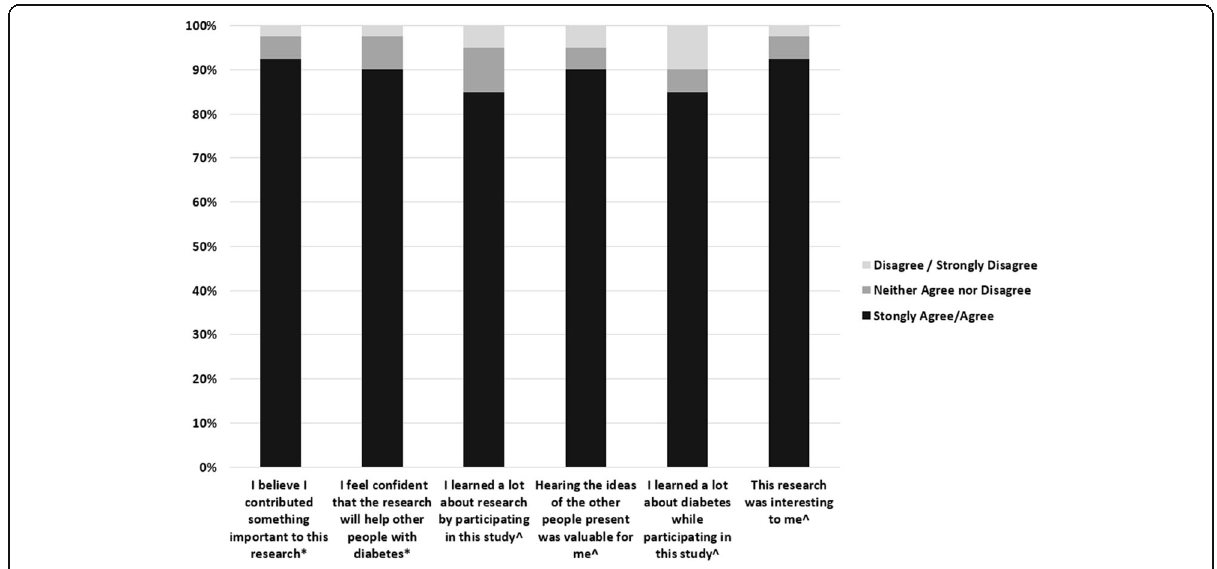
Fig. 1 Patient Engagement* and Personal Value^